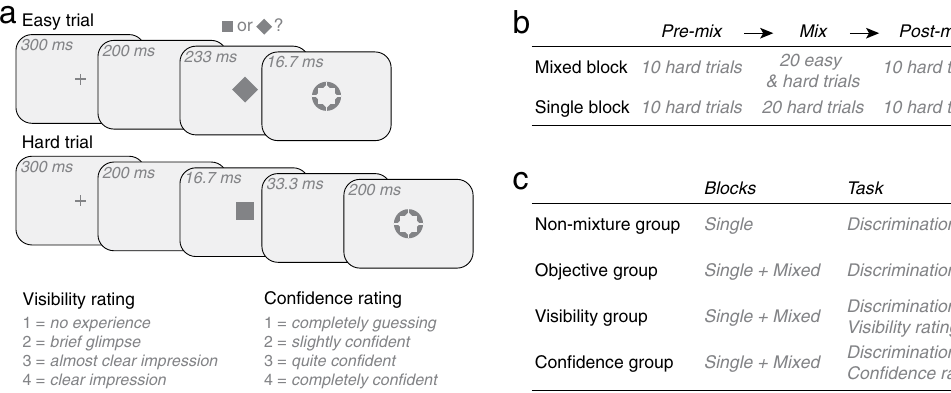
Figure 1. Experimental design. ( a ) On each trial, a square or a diamond was presented either for 233 ms before it was masked, making it easy to recognize (an easy trial); or briefly for 16.7 ms and so it was hard to recognize (a hard trial). ( b ) The presence or absence of easy trials defined two types of blocks: a mixed block that consisted of 10 hard trials, 20 alternating easy and hard trials, and 10 hard trials; a single block consisting of 40 hard trials. ( c ) There were four groups ( n = 28 each) based on the mixture of easy trials and the task. Whereas the non-mixture group trained in 28 single blocks, the objective, visibility, and confidence groups went through 28 interleaving single and mixed blocks (half started with a single block; the other half, a mixed